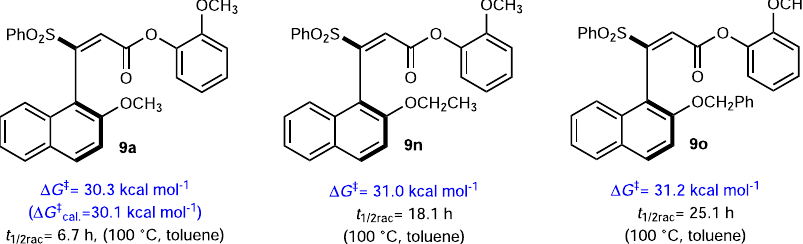
Fig. 3 The rotational barriers ( △ G ‡ ) and half-lives ( t 1/2rac ) of 9a, 9n – 9o. The Δ G ‡ values were obtained via racemization experiment. The Δ G ‡ cal. value was obtained via DFT calculation. The half-lives ( t 1/2rac ) were determined via analysis of experimental data.